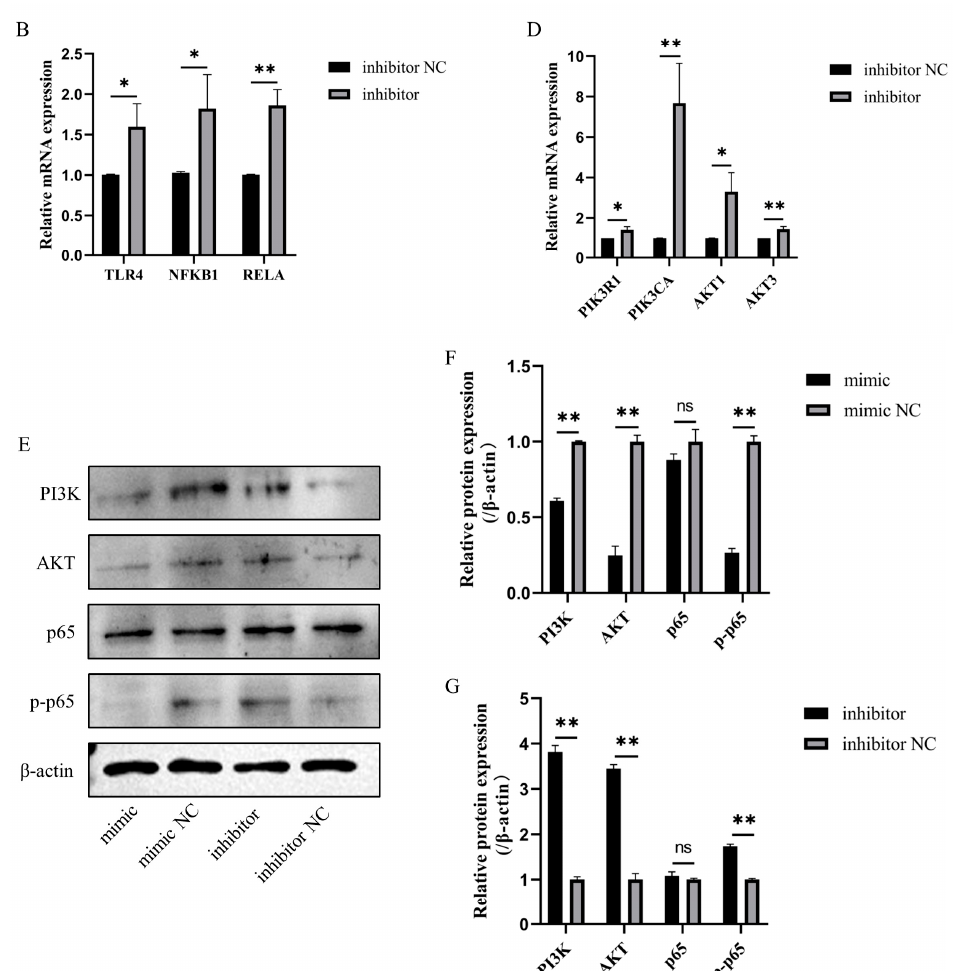
Figure 9. Effects of bta-miR-199a-3p on the LPS-induced PI3K/AKT/NF- κ B pathway. ( A , B ) Effects of overexpression or inhibition of bta-miR-199a-3p on the mRNA expression levels of TLR4, NFKB1, and RELA. ( C , D ) Effects of overexpression or inhibition of bta-miR-199a-3p on the mRNA expression levels of PIK3R1, PIK3CA, AKT1, and AKT3. ( E – G ) Effects of overexpression or inhibition of bta-miR- 199a-3p on the protein expression levels of PI3K, AKT, p65, and p-p65: ( E ) is the result of Western blot, and ( F , G ) are the image analysis results of ( E ) (with β -actin as a standardized correction). * refers to p < 0.05, ** refers to p < 0.01, ns refers to p >